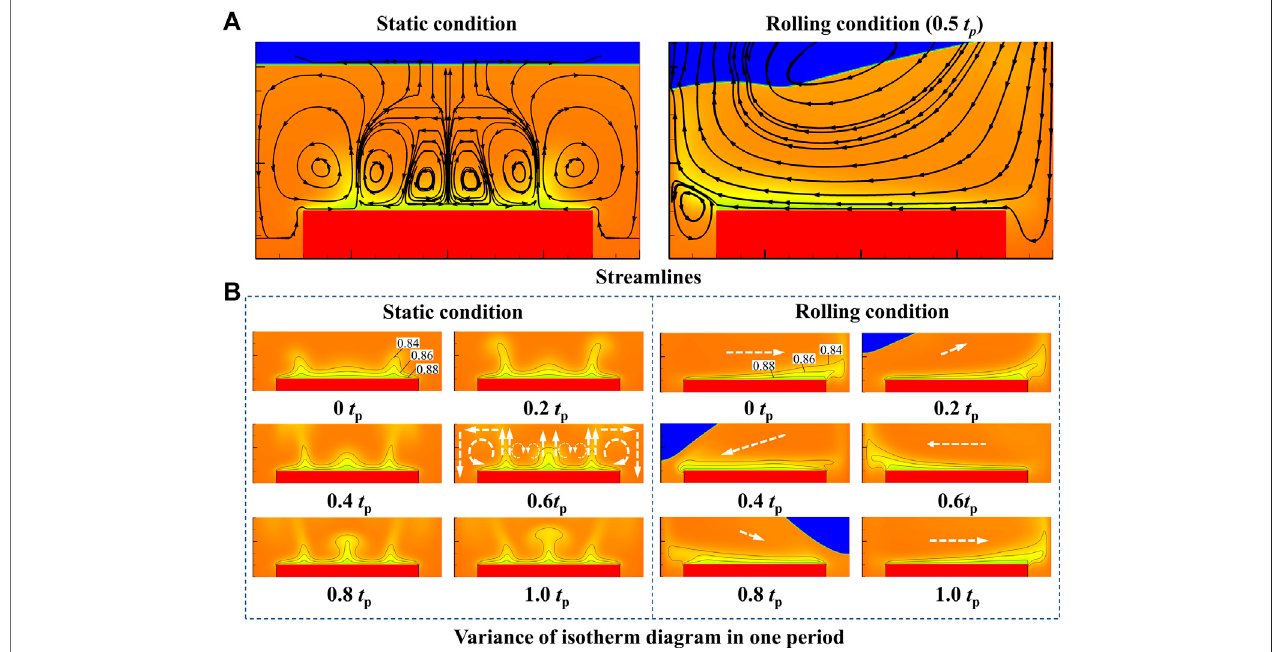
FIGURE 6 | Analysis of convection circulation under both static and rolling conditions: (A) streamlines of the fl ow fi eld; (B) variance of isotherm diagram in one period.